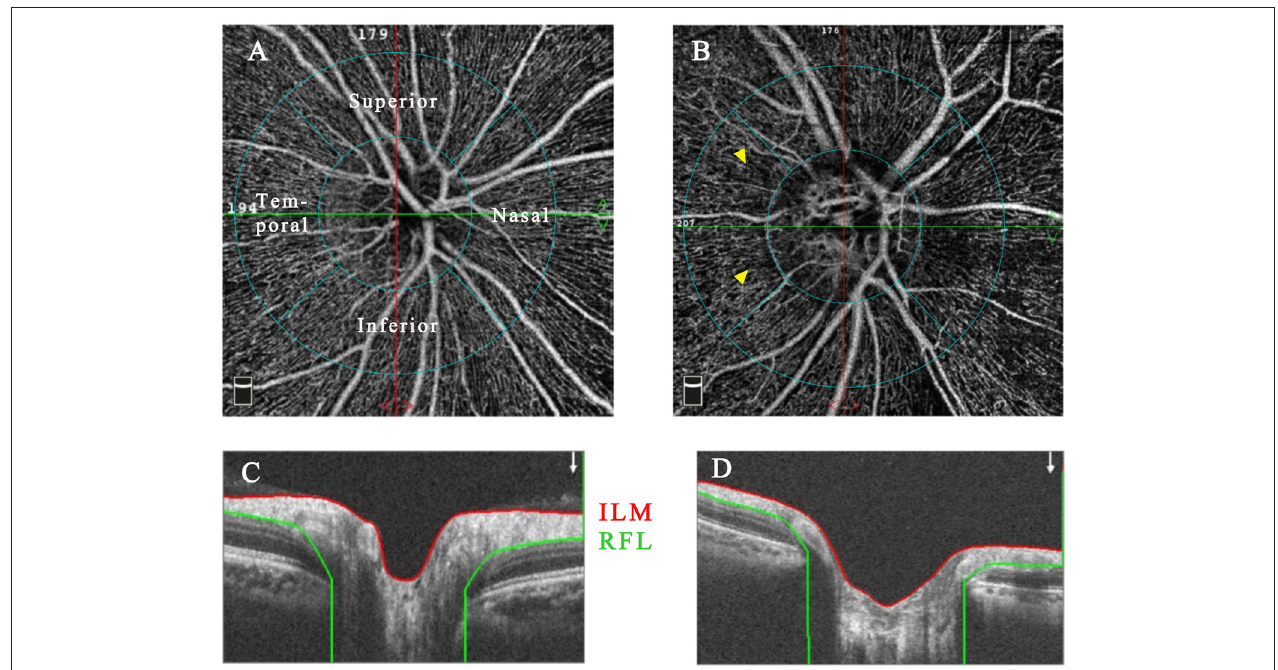
FIGURE 2 | The representative RPCN OCTA images with accompanying B-scan images of healthy (A,C) and Behcet’s uveitis eyes (B,D). RPCN images were acquired between the ILM and NFL within a 4.5 × 4.5-mm cube scan centered on the optic disc. The peripapillary region was an annular area with 1-mm-width, and the inner concentric ring was defined by the disc boundary. Grayish areas of capillary non-perfusion/hypoperfusion were observed in OCTA images of a Behcet’s uveitis patient (yellow arrowhead). OCTA, optical coherence tomography angiography; RPCN, radial peripapillary capillary network; NFL, nerve fiber layer.